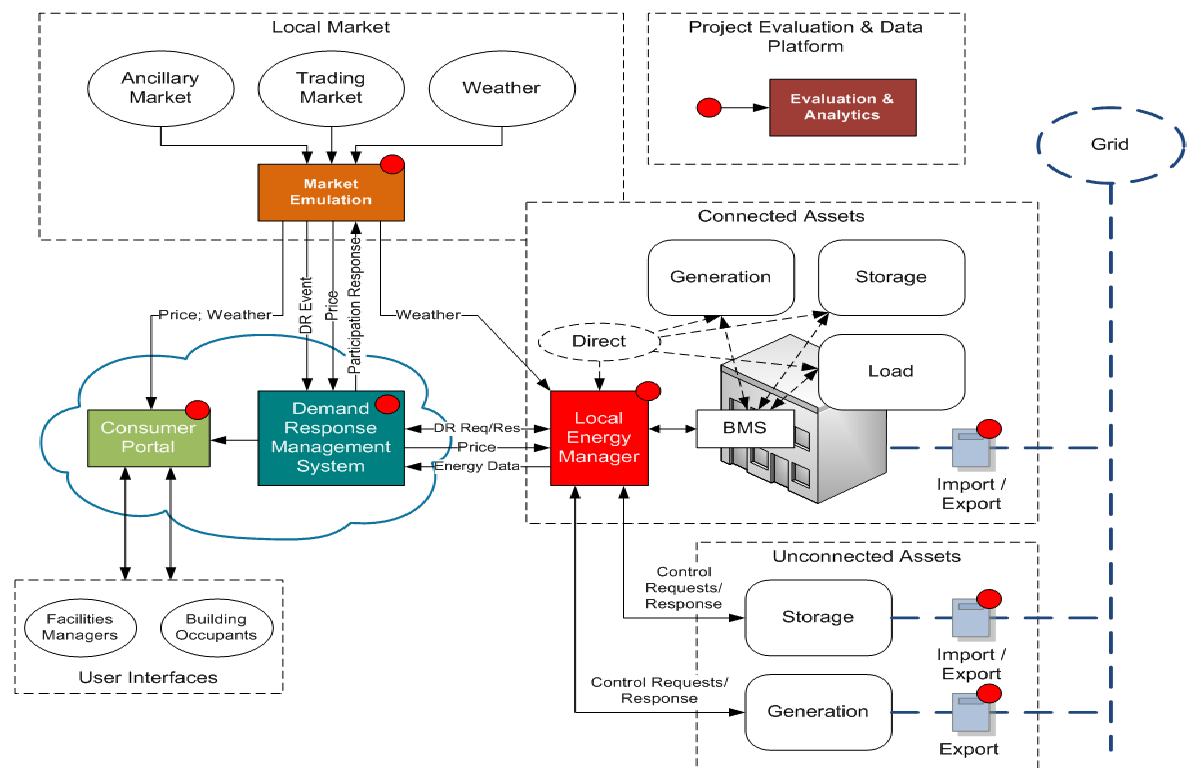
Figure 2. Demand response system overview.